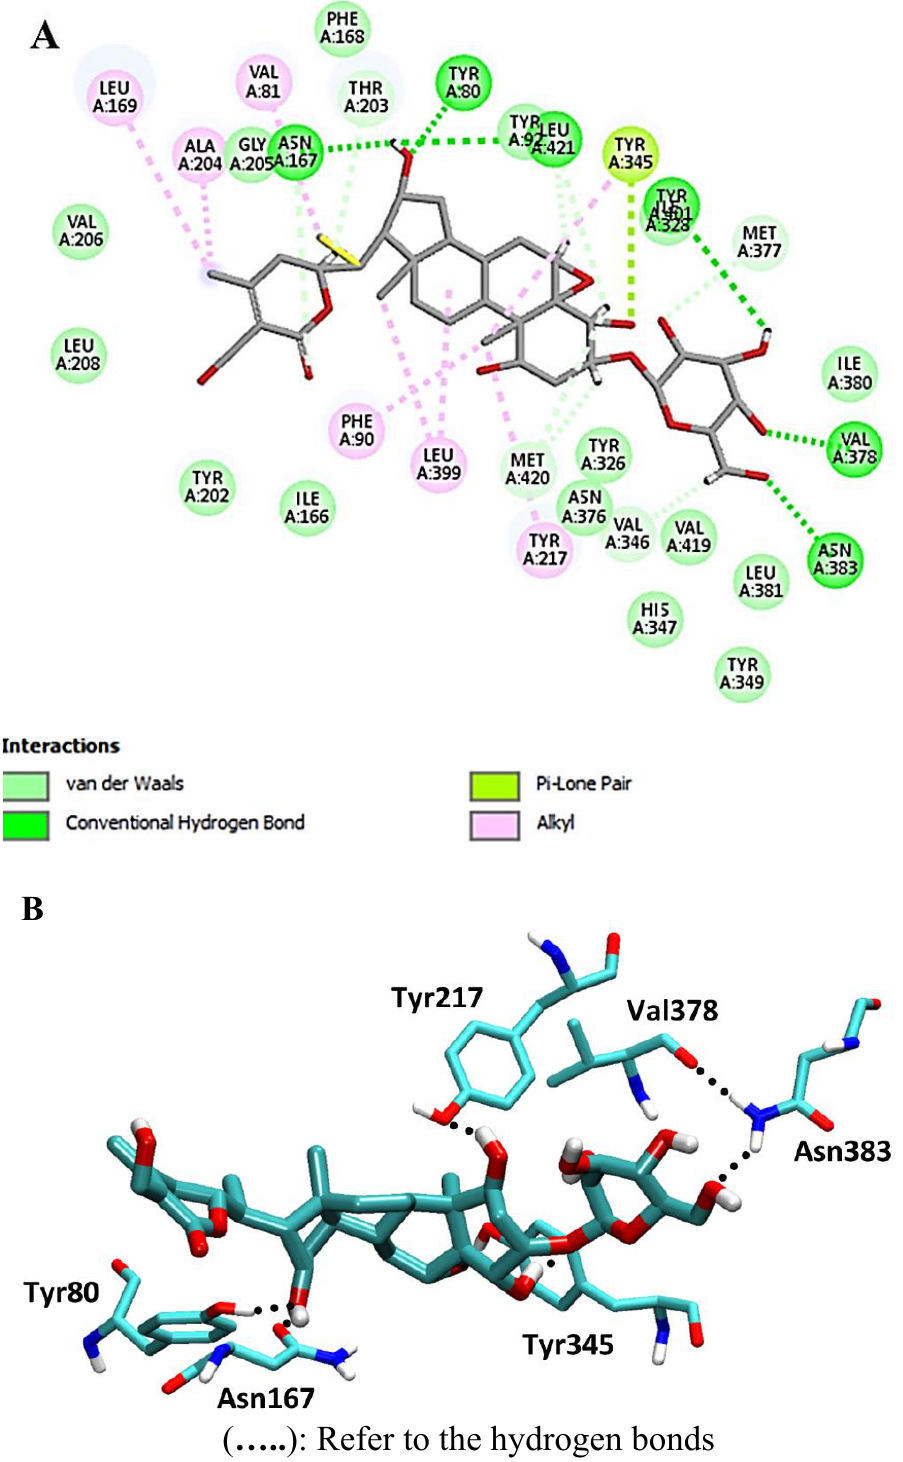
Figure 5. 2D and 3D interaction complex of 4,16-dihydroxy-5,6-epoxyphysagulin D with NMT (( A ) and ( B ), respectively). The flavonoid glycoside calycopteretin 3-rutinoside was found to have a potential affinity with a pose score value of −23.3 kcal/mol (RSMD = 1.24 Å) with a hydrogen-bond interaction with Met-420 and Leu-421 as H-donor in addition to Tyr-80 as H-acceptor (Figure 6).